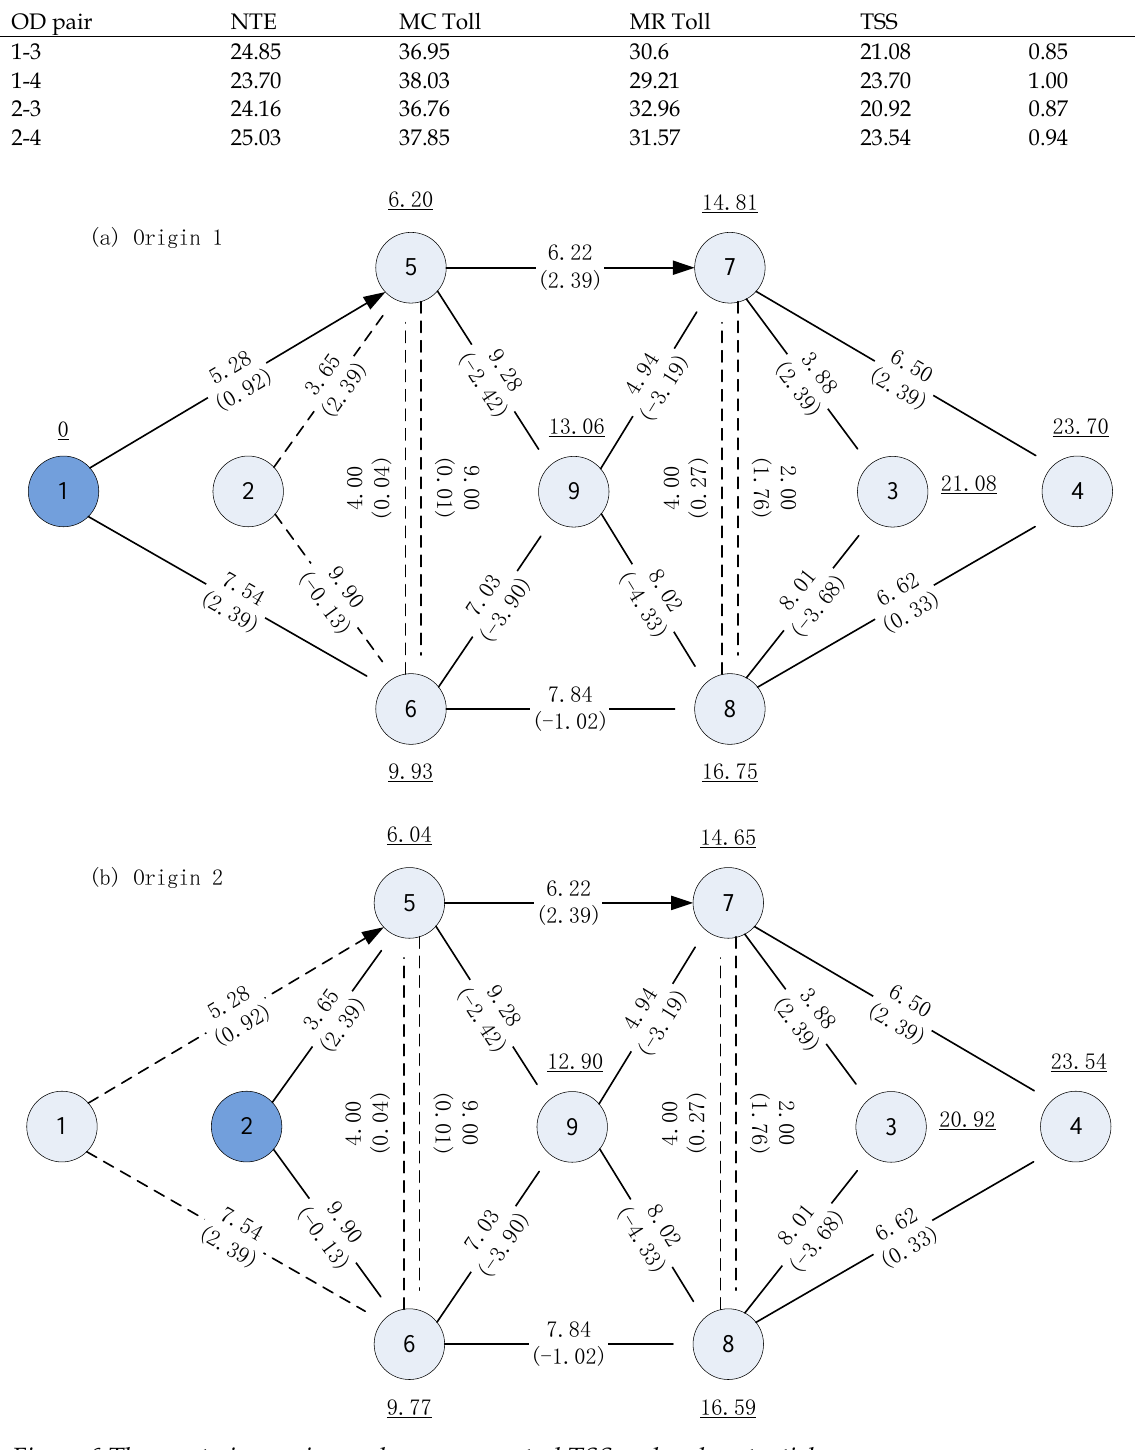
Figure 6 The pareto-improving and revenue-neutral TSS and node